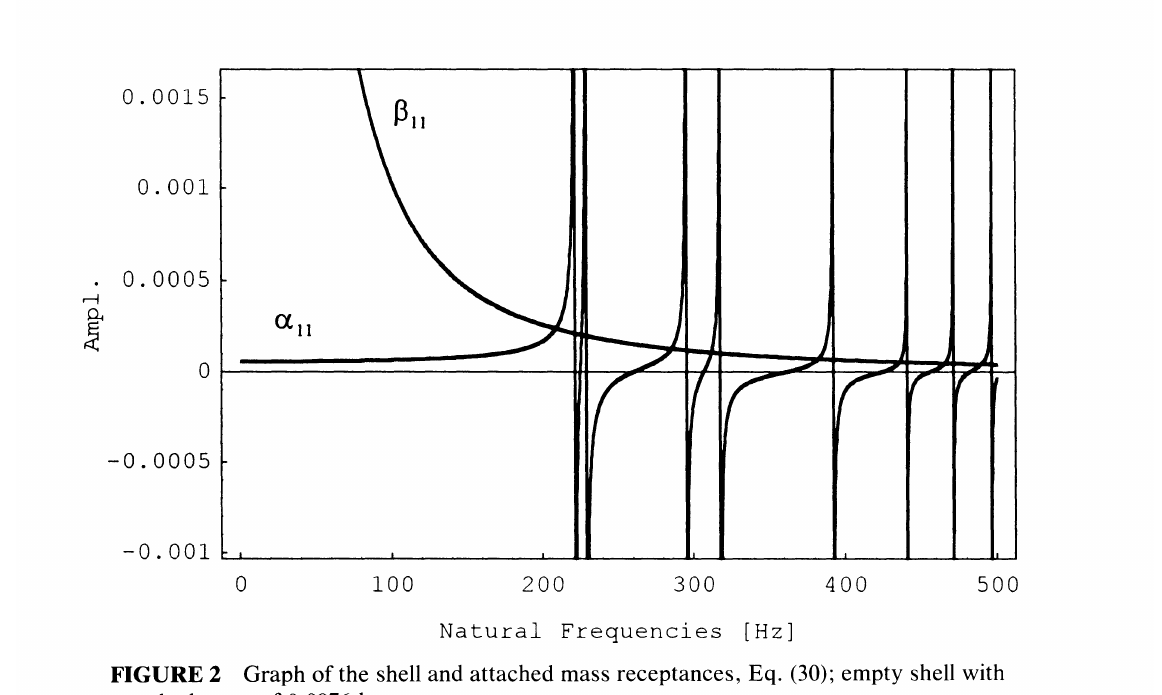
FIGURE 2 Graph of the shell and attached mass receptances, Eq. (30); empty shell with attached mass of 0.0976